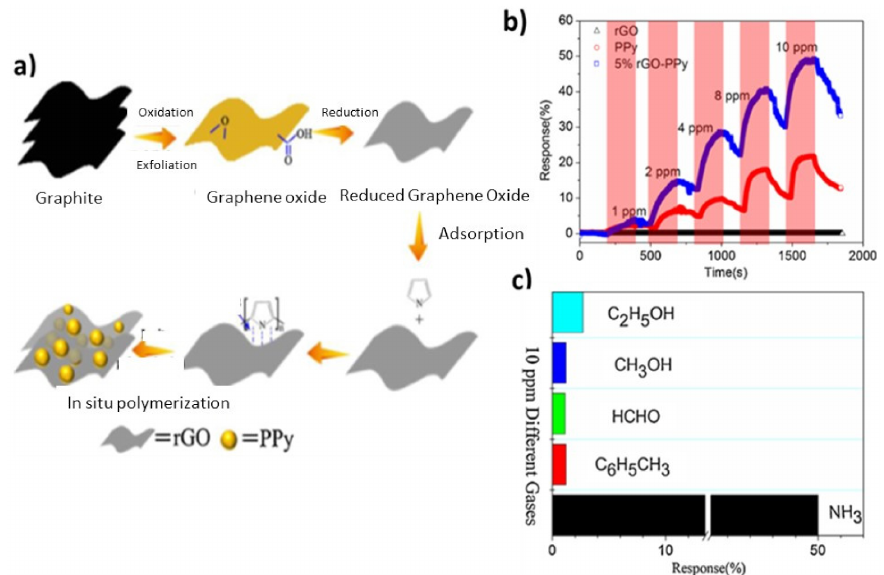
Figure 13. ( a ) In situ polymerization of polypyrrol onto rGO via oxidative exfoliation and reduction. ( b ) Response of rGO, neat PPy, and rGO/PPy nanocomposite to 1–10 ppm of NH 3 . ( c ) Selectivity of rGO/PPy to different gases at a concentration of 10 ppm. Adapted from [98], copyright 2017, with permission from Elsevier.